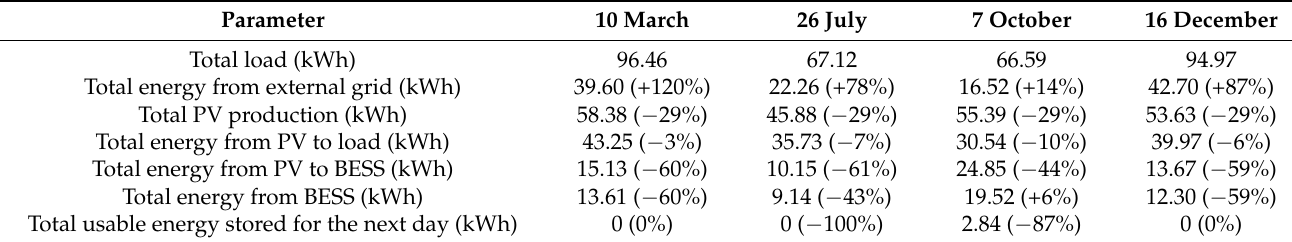
Table 6. Energy mix total values for scenario A.